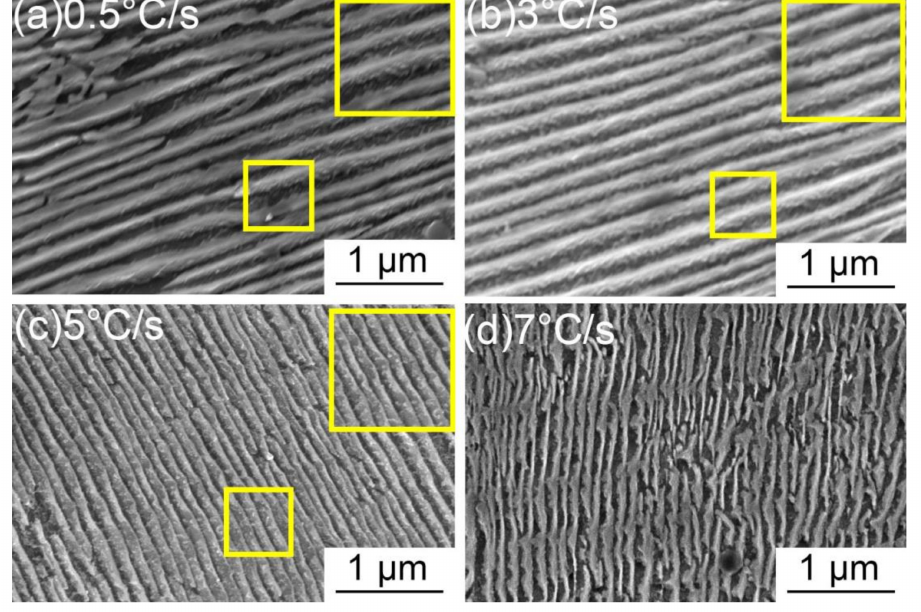
Figure 8. Microstructure of the specimens cooled at ( a ) 0.5 ◦ C / s, ( b ) 3 ◦ C / s, ( c ) 5 ◦ C / s, and ( d ) 7 ◦ C / s after